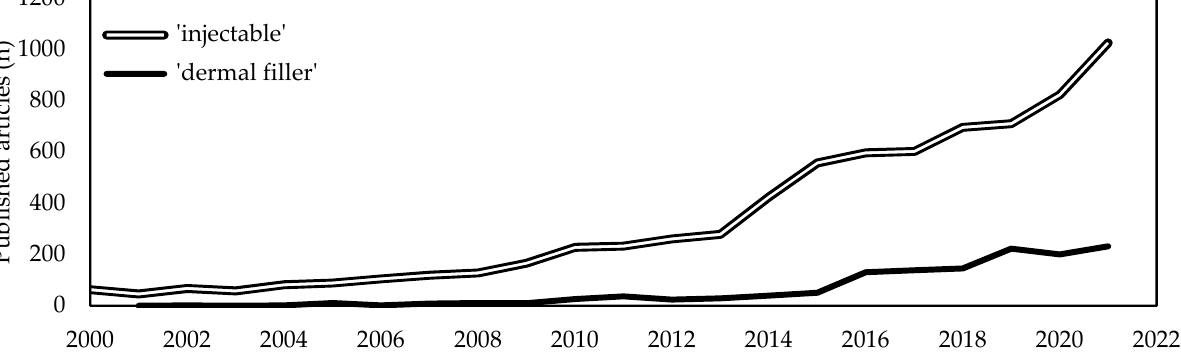
Figure 1. The increasing research interest in injectable formulations and dermal filler. Articles indexed in Scopus (www.scopus.com) with the keywords ‘injectable’ and ‘dermal filler’ and published from 2000 to 2022 (last accessed on 27 May